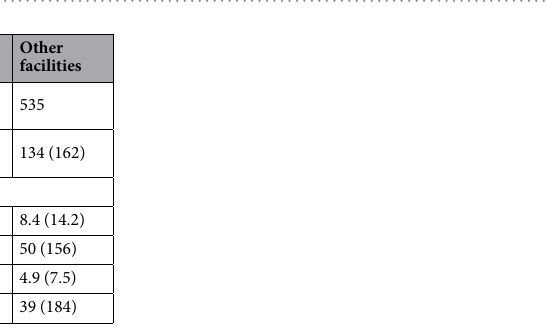
Figure 1. Facility transfer network. The network consists of facilities that are connected by daily transfers of patients, here aggregated over the two-year period. Edge color encodes the number of patients transferred through each connection. The insets show this network around Boston (upper inset) and around Los Angeles (lower inset). The maps were created using the Basemap Matplotlib Toolkit 1.0.8 (http://matplotlib.org/ basemap/) for Python 24 .